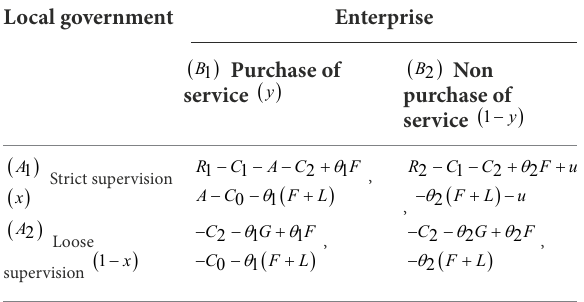
TABLE 1 Game payoffs matrix between the local government and the